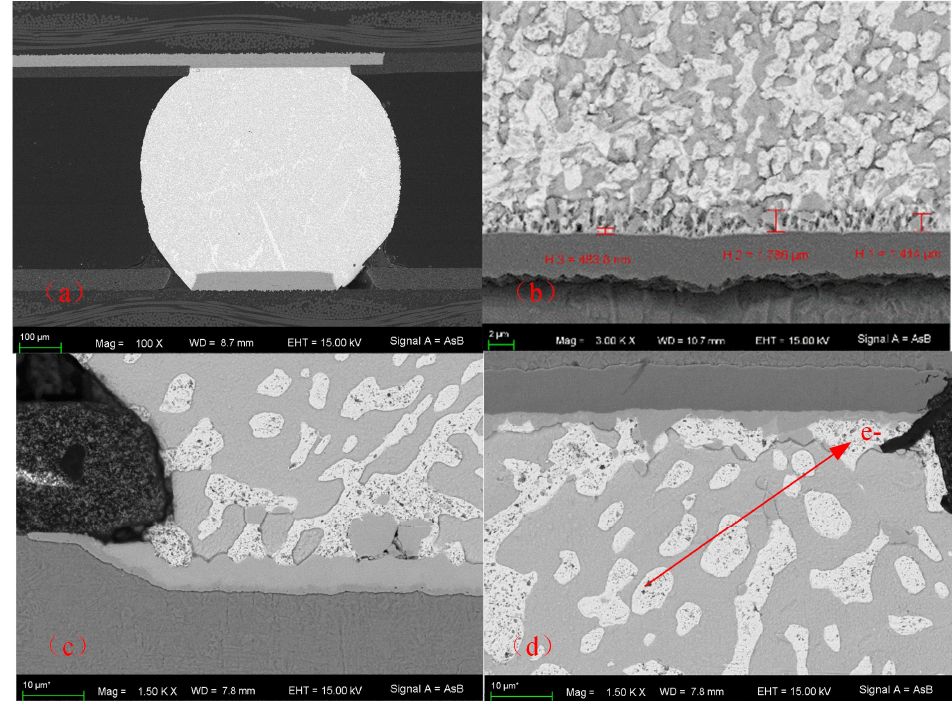
Figure 12. SEM image of BGA ( a ) Before electromigration experiment ( b ) SEM image of IMC ( c ) SEM image at the anode after the electromigration experiment ( d ) SEM image at the cathode after the electromigration experiment.